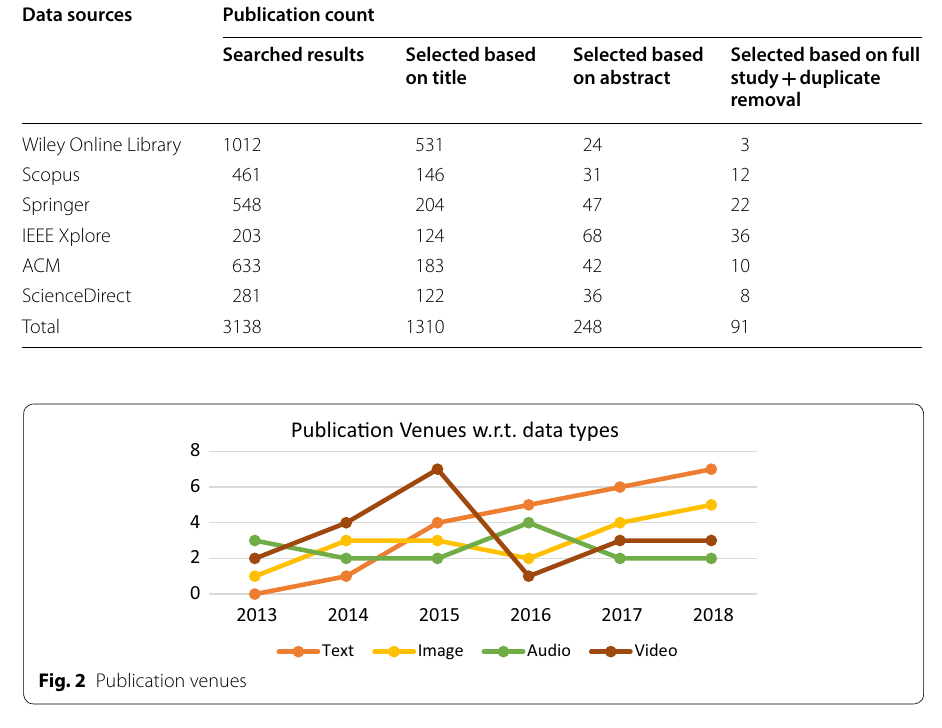
Table 2 Data sources and publication for each step of phase 2 of